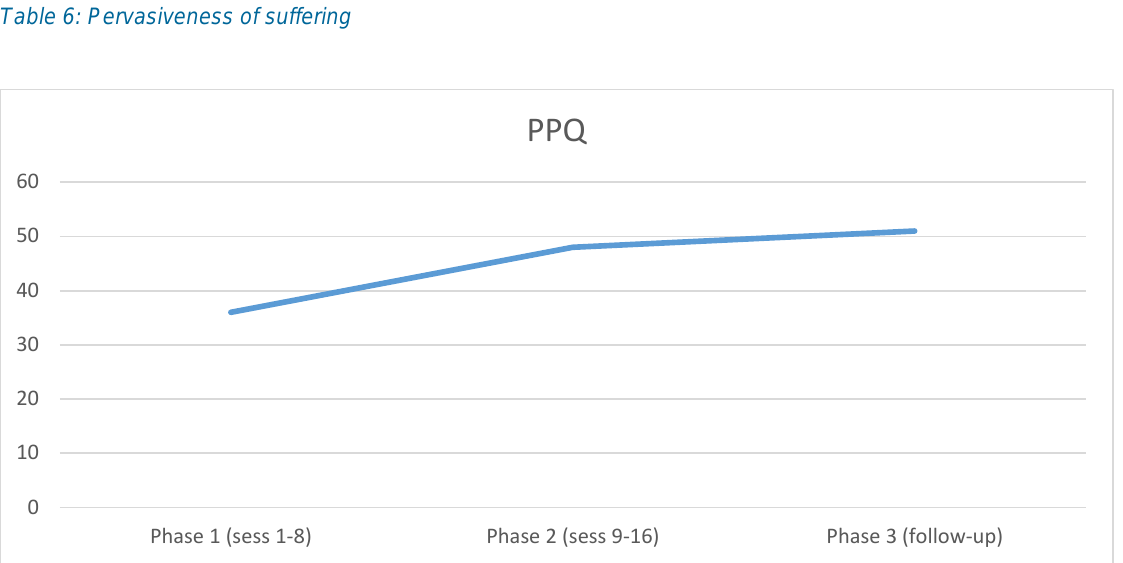
Table 6: Pervasiveness of suffering